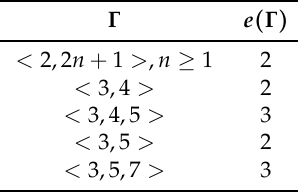
Table 1. List of Numerical semigroups Γ for which G ( Γ ) is complete.